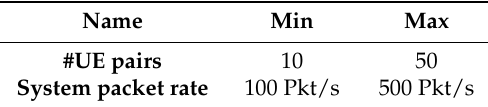
Table 2. Parameter range for factorial